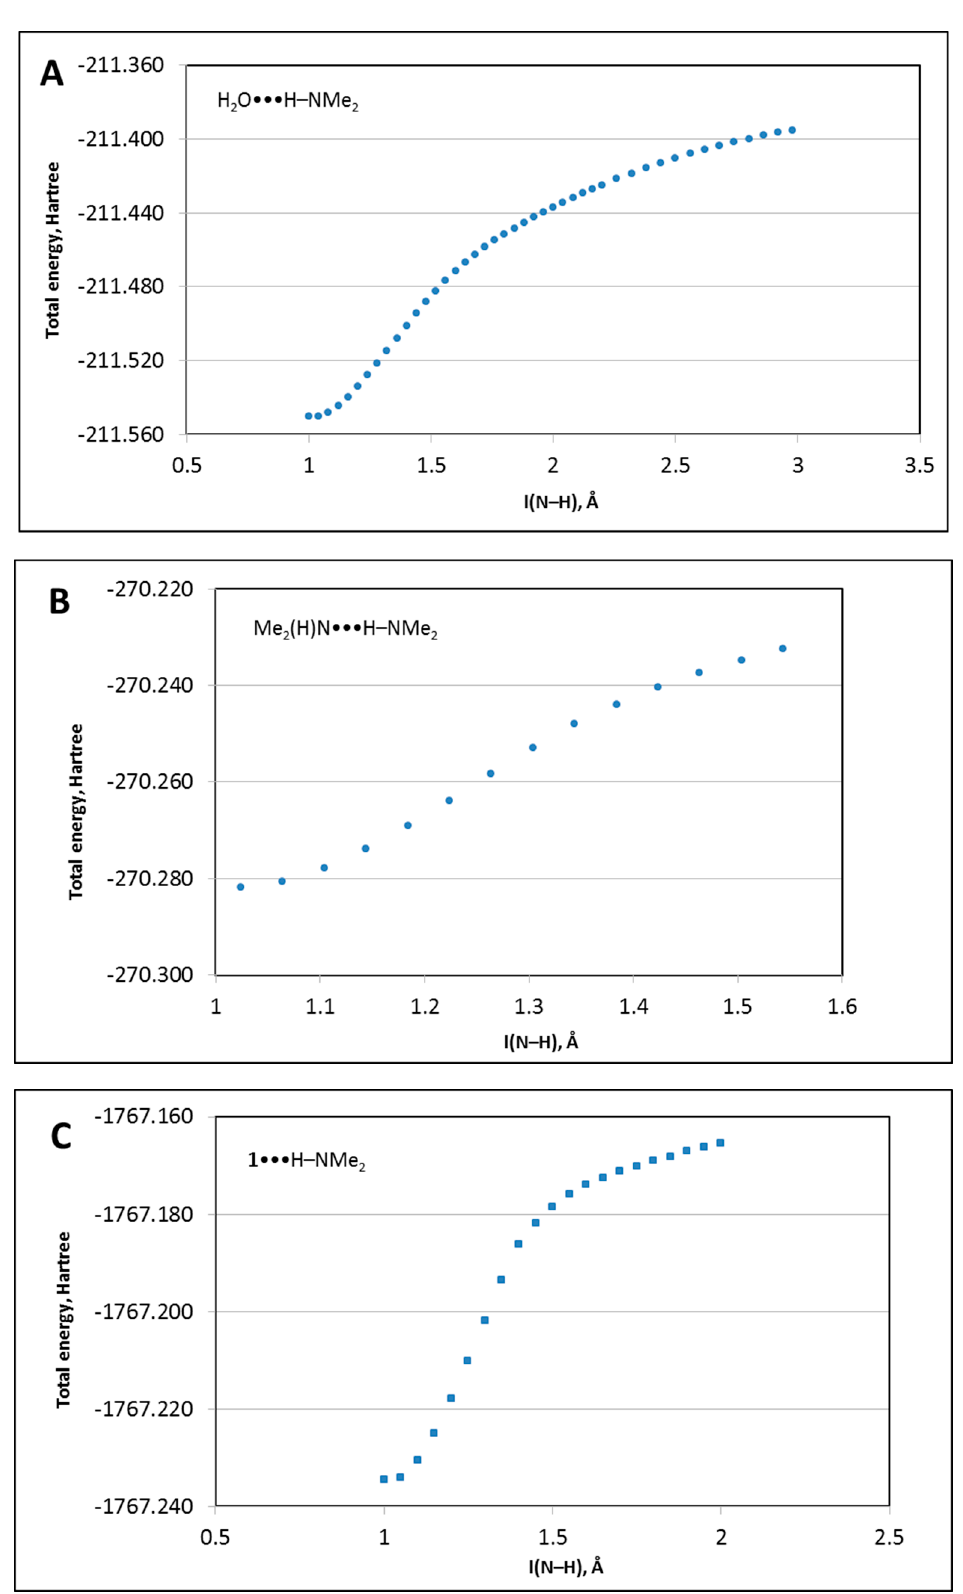
Figure 2. Total energy vs. the N–H distance in the systems H 2 O···H–NMe 2 ( A ), Me 2 (H)N···H–NMe 2 ( B ), and 1 ···H–NMe 2 ( C ).